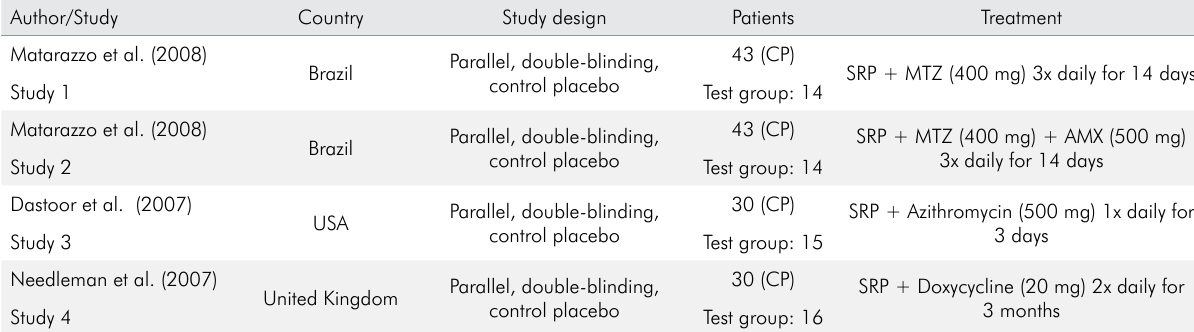
Table 2. Studies listed in meta-analysis.